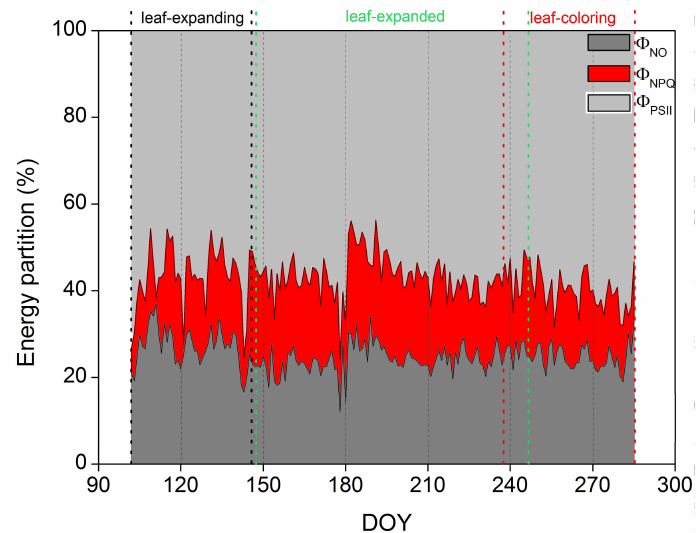
Figure 6. Timeseries of percentage of energy partitioning during the 2014 growing season. The red area is the quantum yield of regulatory (light-induced) energy dissipation ( Φ NPQ ); the gray area is quantum yield of constitutive non-regulatory (basal or dark) energy dissipation ( Φ NO ); and the light gray area is the quantum yield of light-induced photochemical quenching, which is equal to effective quantum yield of PSII photochemistry ( Φ PSII ). Each phenophase is identified with a different color of dot